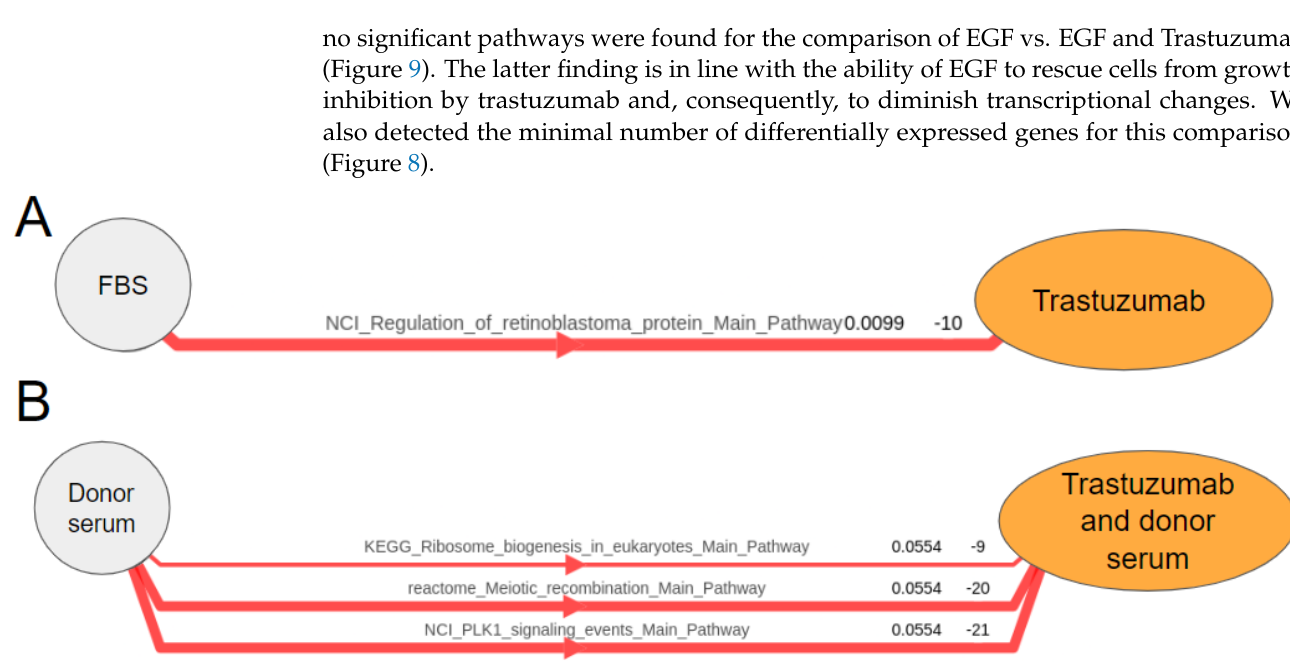
Figure 9. Pathway activation charts for the comparisons of BT474 cells with and without trastuzumab added. Red lines show most strongly inhibited pathways (ordered bottom to top). Thickness is proportionate to absolute value of PAL. RNA sequencing gene expression profiles of BT474 cells with and without trastuzumab were compared in the presence of ( A ) FBS only or ( B ) donor serum. PAL values and FDR-adjusted t -test p -values are shown to the right of the pathway names.